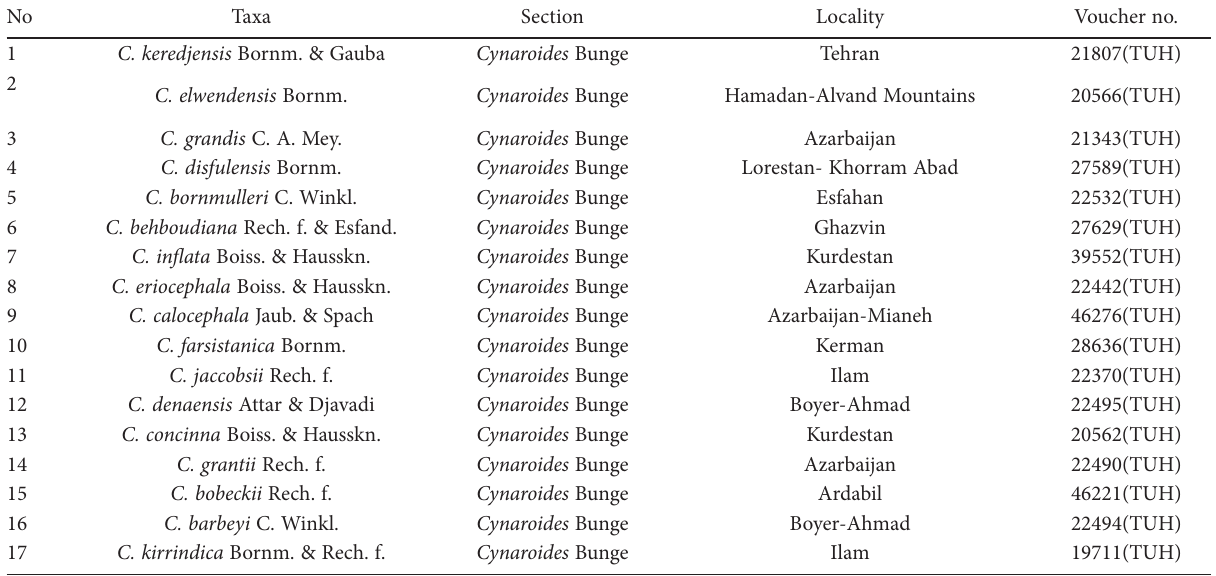
Table 1. Investigated Cousinia species and their voucher information. No Taxa Section Locality Voucher